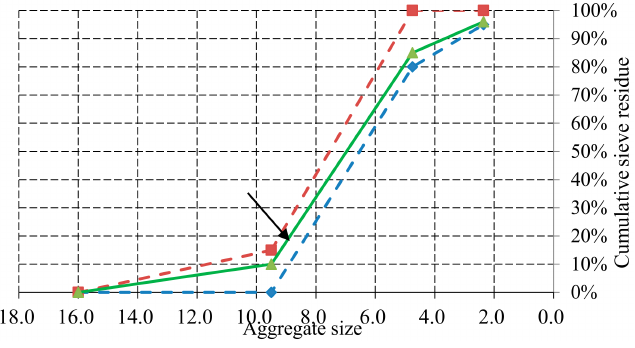
Figure 3. Aggregate gradation of coarse aggregate in RCA. Table 1. Proportion of ordinary concrete and recycled aggregate